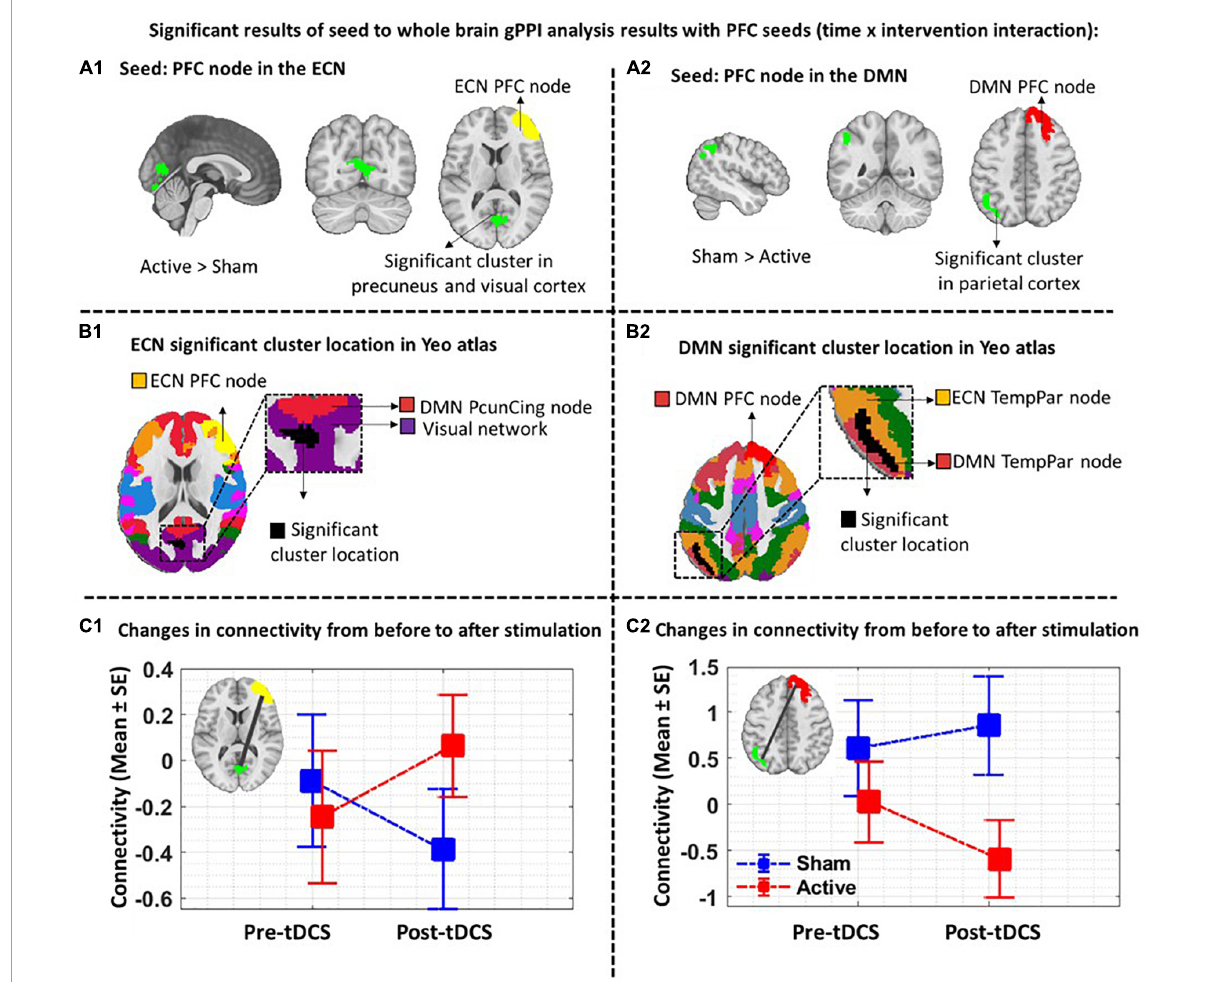
FIGURE4 Task-modulated (cue reactivity) connectivity analysis. First row: Significant results of the seed-to-whole brain gPPI analysis results with PFC seeds (time × intervention interaction): The PFC nodes in ECN, DMN, and VAN were used separately for the seed-to-whole brain gPPI analysis. Voxel-level threshold: P uncorrected < 0.01 and cluster level threshold: P FDR corrected < 0.05. No significant seed to whole-brain gPPI results were found with the VAN PFC node as a seed. Significant clusters with PFC nodes in ECN and DMN are depicted. (A1) Significant cluster (located in the visual and the precuneus cortex with 515 voxels and (6, –48, –12) peak coordinate in MNI space) in gPPI analysis with PFC node in ECN. Time × intervention interaction showed increased task-based connectivity in the active tDCS compared to sham (a2). Significant cluster (located in parietal cortex with 480 voxels and (–48, –60, 46) peak coordinate in MNI space) in gPPI analysis with PFC node in DMN. Time × intervention interaction showed decreased task-based connectivity in the active condition compared to sham. (B1,B2). Significant gPPI clusters with respect to the large-scale network topology in the Yeo atlas. (C1,C2) . Connectivity changes from before to after tDCS. Connectivity changes (Mean ± SE) from the first scan (pre-tDCS) to the second scan (post-tDCS) between ECN PFC node and gPPI active cluster (green cluster) (left panel) as well as between DMN PFC node and gPPI active cluster (blue cluster) (right panel) are depicted for both active (in red) and sham (in blue) stimulation conditions. Axial slices are shown in neurological convention. EF, electric field; gPPI, generalized